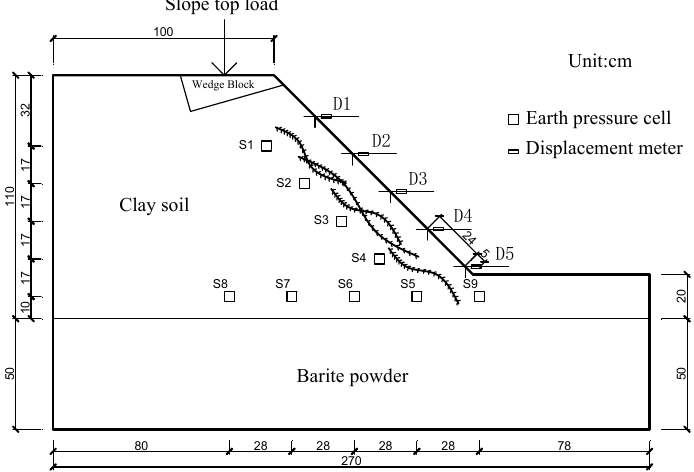
Figure 3. Test G1–G3 sensor arrangement.